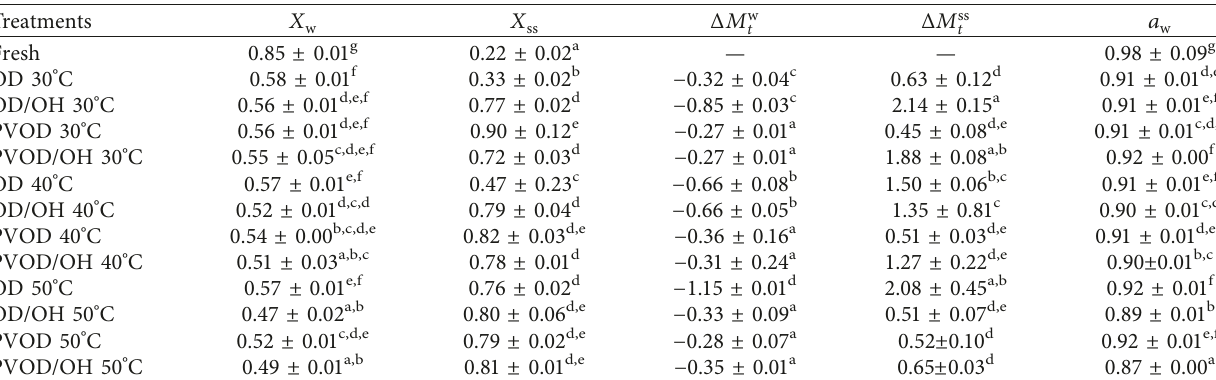
w ), soluble solids mass